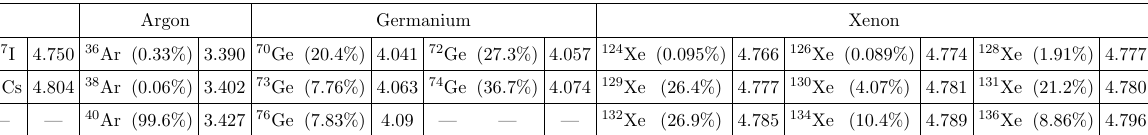
Table 1 . Rms radii (in fm) of the proton density distributions of the stable isotopes of cesium, iodine, argon, germanium and xenon [16]. The relative abundances of the Ar, Ge and Xe isotopes are provided in